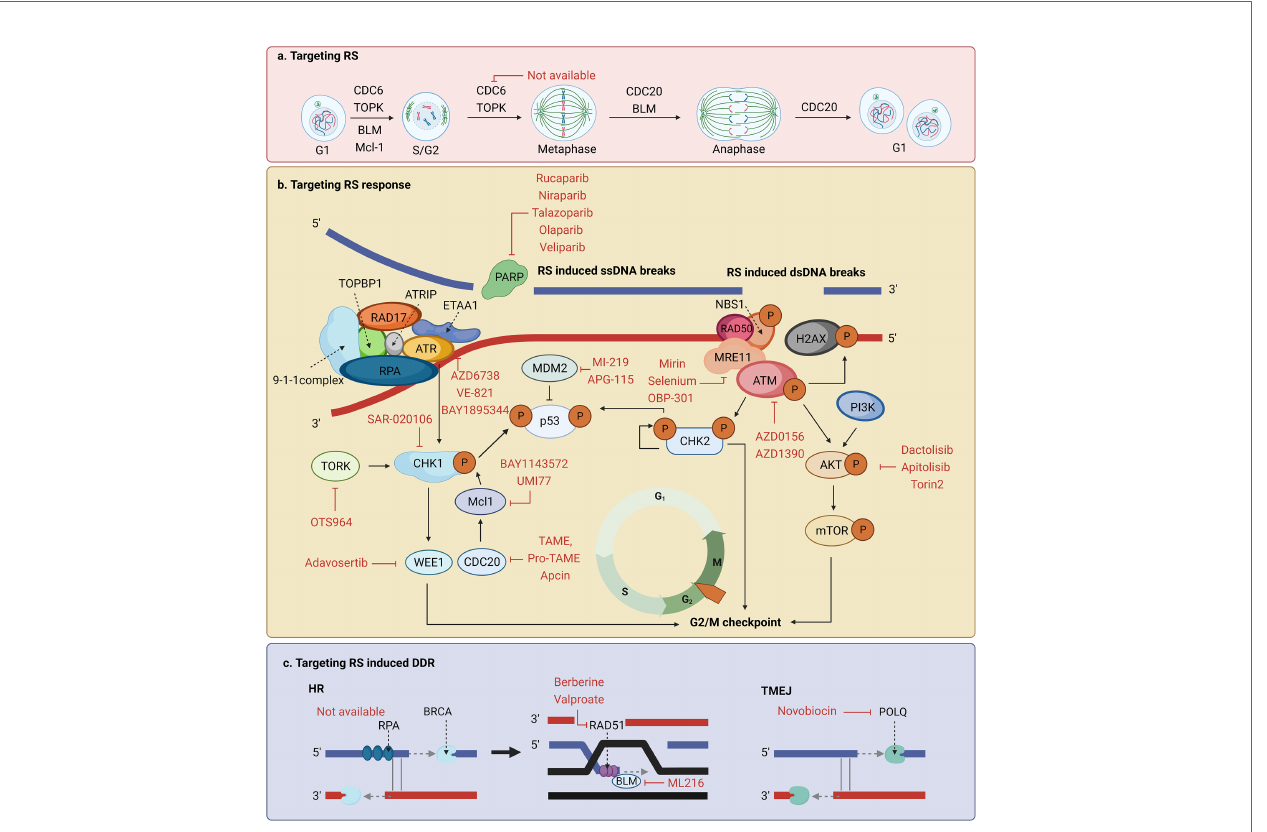
FIGURE 4 | Potential targets and corresponding inhibitors of (A) the replication stress (RS), (B) the RS response, or (C) RS-induced DNA damage response (DDR) that have been previously